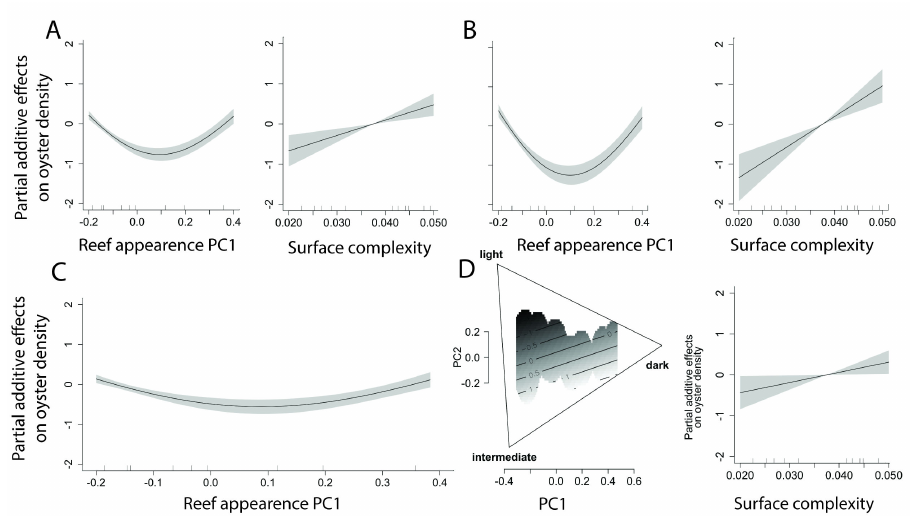
Figure 2. Partial additive effects of fitted GAM models by oyster size class: ( A ) total, ( B ) recruit (<25 mm), ( C ) submarket (25–76 mm), ( D ) market ( ≥ 76 mm). Tick marks along the x -axis are the observed data points. Gray shading represents ± 2 standard error confidence bands. Panel ( D ) includes a PCA plot where contour lines and shading represent partial additive effects on market oyster density, with the darker shading indicating the minimum. Y -axes and contour units are log transformed oyster density due to the log link function applied in the GAM models.